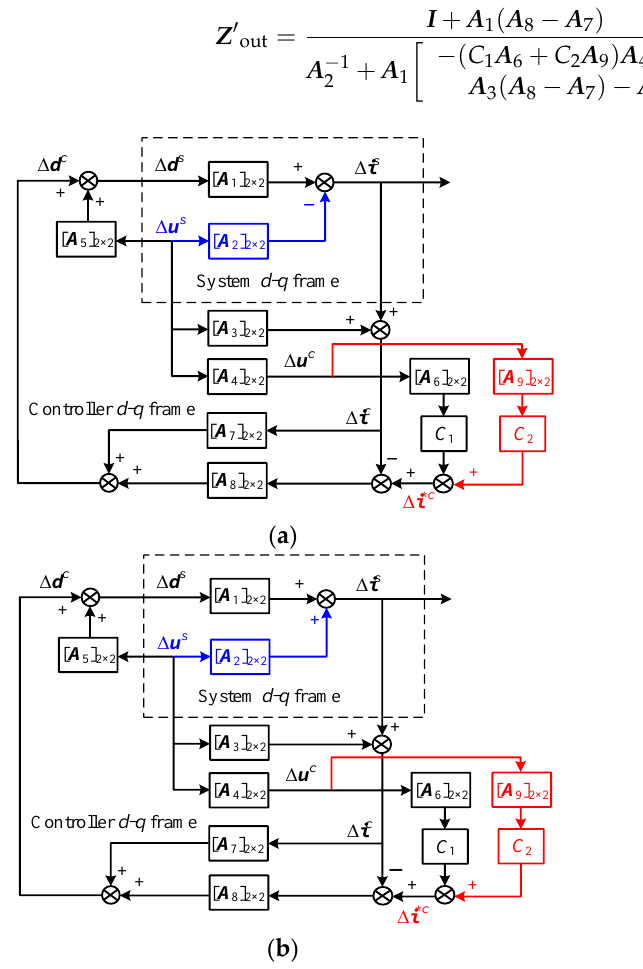
Figure 10. Converter small-signal block diagram under IRSE control: (a) in the forward power direction and (b) in the reverse power direction.